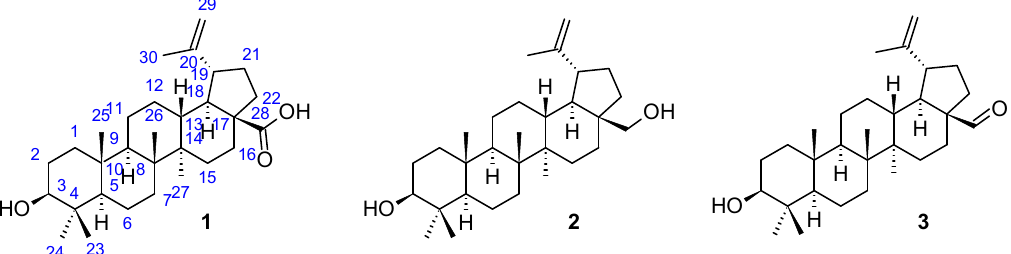
Figure 1. The structures of betulinic acid ( 1 ) with carbon atom numbering), betulin ( 2 ), and its aldehyde ( 3 ).